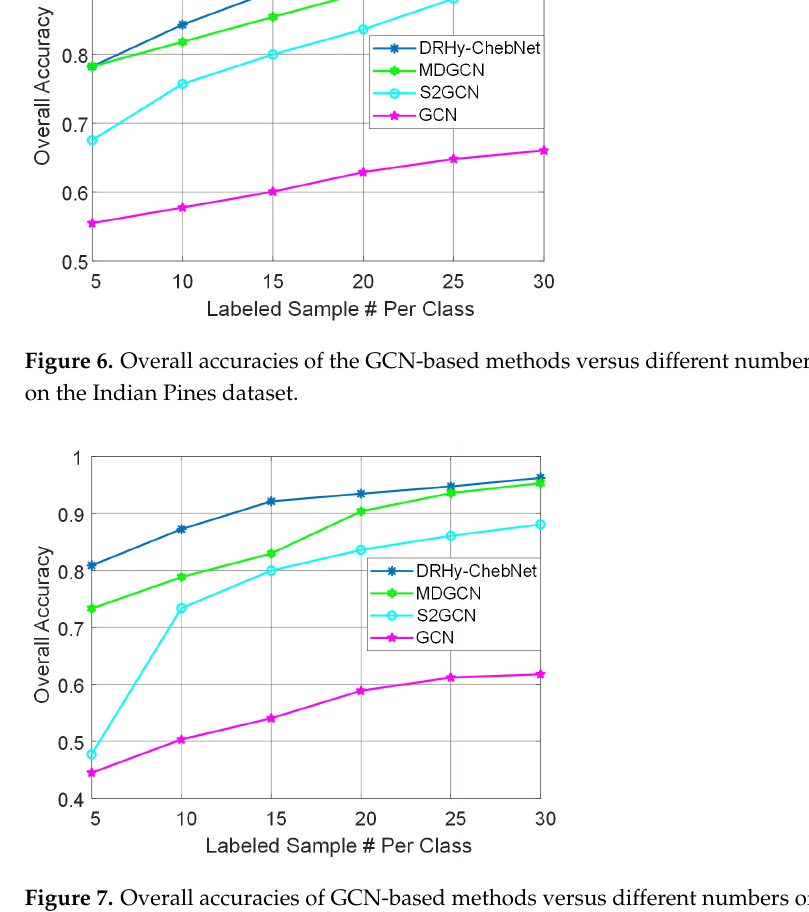
Figure 7. Overall accuracies of GCN-based methods versus different numbers of labeled samples on the University of Pavia